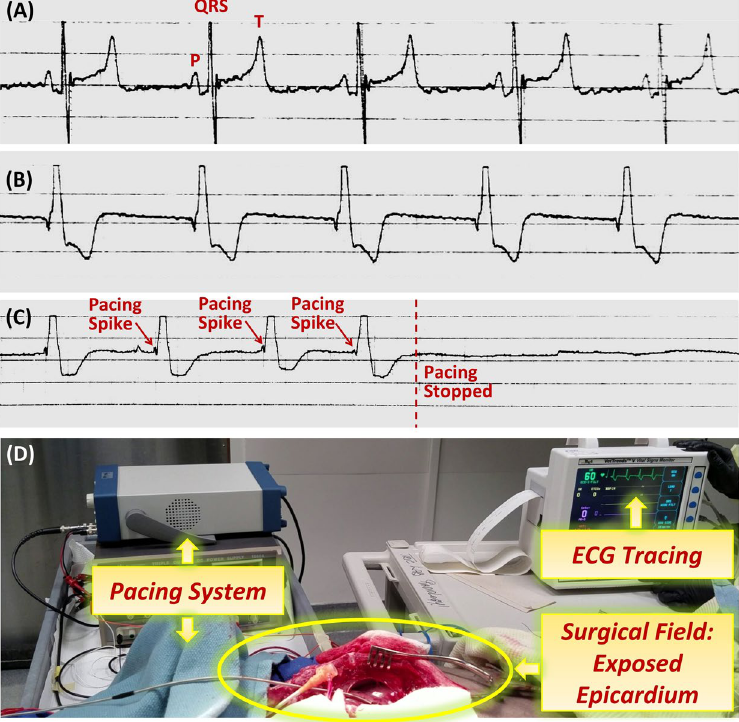
Figure 6. Animal Experiments. ( A ) Prior to euthanasia of the animal, ECG recordings revealed a heart rate of 77 BPM, MAP of 90 mmHg, and normal P, QRS, and T waves that indicate normal sinus rhythm. ( B ) After euthanasia and during the pacing period, ECG recordings revealed a heart rate of 60 BPM and MAP of 37 mmHg. The wide-complex paced rhythm indicates successful pacing via the remote controlled wireless pacing system. ( C ) Zoomed-in view of the ECG tracing highlights the pacing spikes that appropriately stimulates ventricular contraction. When pacing was deactivated, electrical activity was absent as indicated by a flat line on the ECG, thus supporting the pacer-dependency of the post-mortem animal’s heart and effectiveness of the remote-controlled pacemaker’s ability to stimulate appropriate electrical activity in the mammalian heart. ( D ) Wide-angle image highlights the setup for post-euthanasia pacing of a pig heart accompanied by simultaneous ECG